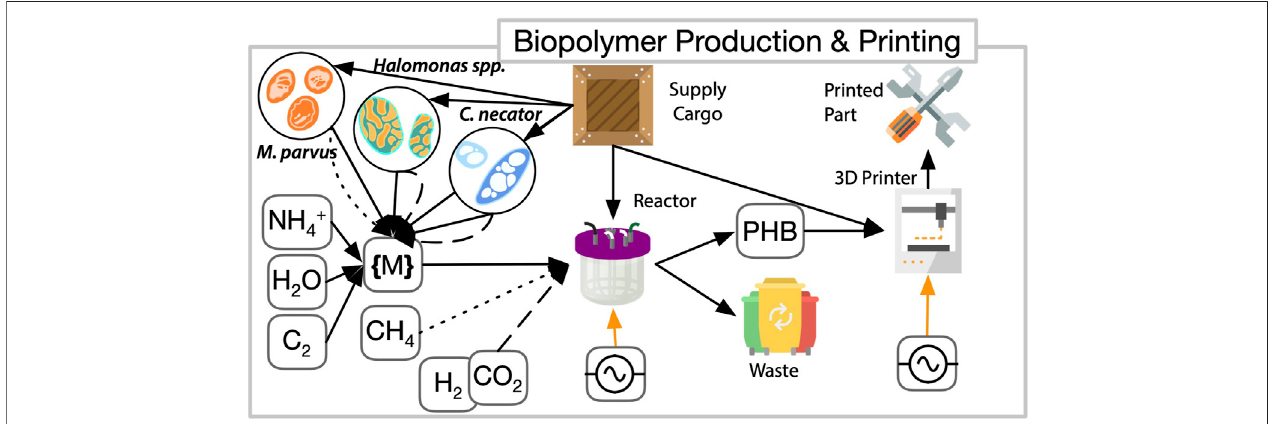
FIGURE4| ISM(greyin Figure2 )systemsbreakdownforbiomanufactoryelementsofbiopolymerproductionand3D-printing.3Dprintedpartsarefabricatedfrom bioproduced plastics. Biopolyesters such as PHB, along with corresponding waste products, are formed in cargo-supplied reactors with the aid of microorganisms. A variety of available carbon feedstocks can serve as substrates for aerobic auto-, hetero-, or mixotrophic microorganisms such as Cupriavidus necator , Methylocystis parvus and Halomonas spp.AllthreemicrobesarecapableofusingC 2 feedstocks(likeacetate,indicatedbysolidline),while C.necator and Methylocystis canalso use C 1 feedstocks. The former utilizes a combination of CO 2 and H 2 (large dotted line), while only M. parvus can leverage CH 4 (small dotted line).